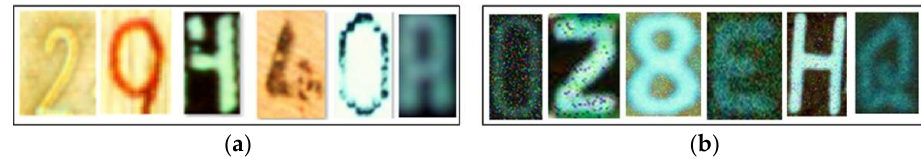
Figure 9. ( a ) Example of corrupted data ( b ) Example of noisy